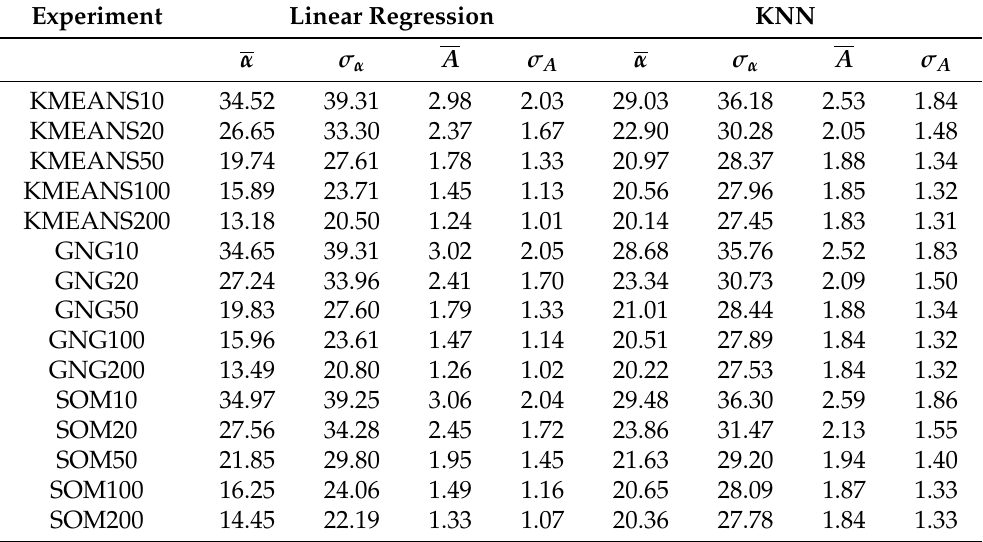
Table 2. Table showing the reconstruction error measured as the average angular and amplitude error ( α and A ) and its standard deviation ( σ α and A ) for linear regression and KNN for sensor location selection using the k-menas, GNG, and SOM algorithms with the additional criteria (alternative algorithm setting). The amplitude is given in m/s, the angle in